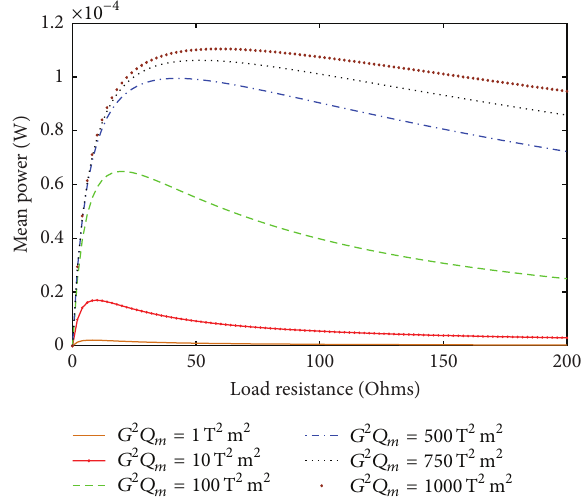
Figure 2: Mean power as a function of load resistance for different values of 𝐺 2 𝑄 𝑚 .